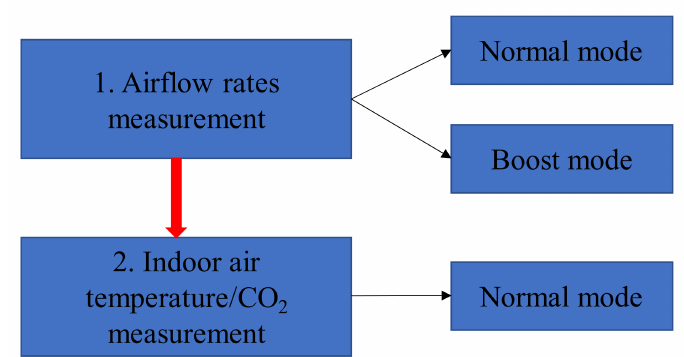
Figure 3. The flowchart of measurement.